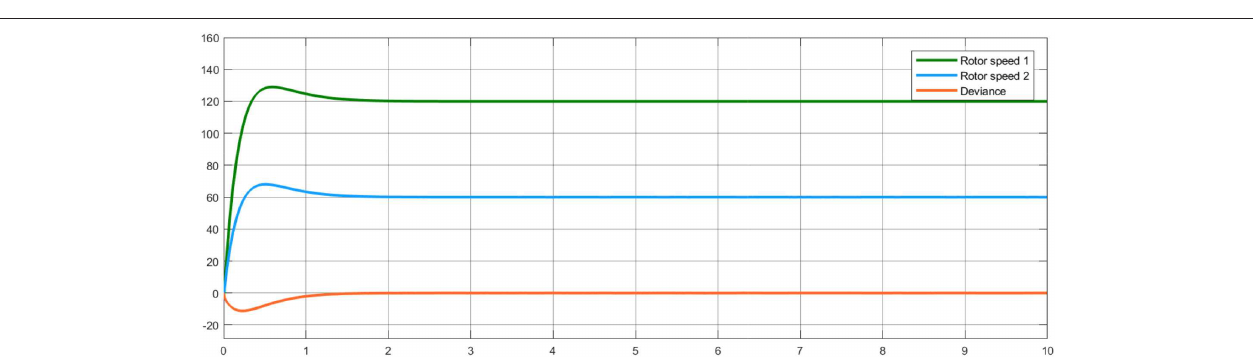
FIGURE 13 | Simulation results of model without collaborative